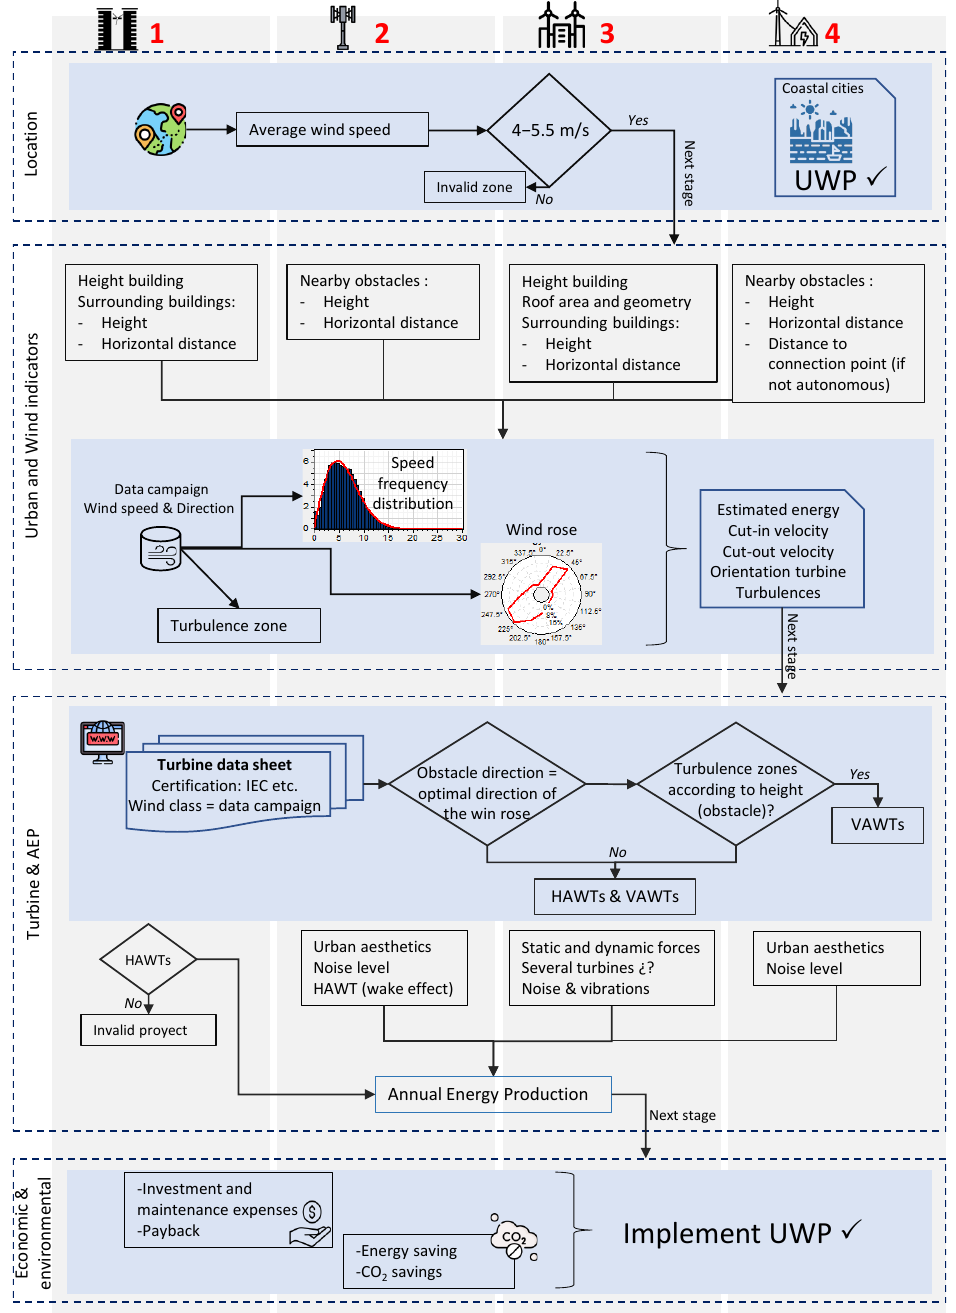
Figure 4. Proposed framework. Authors’ own